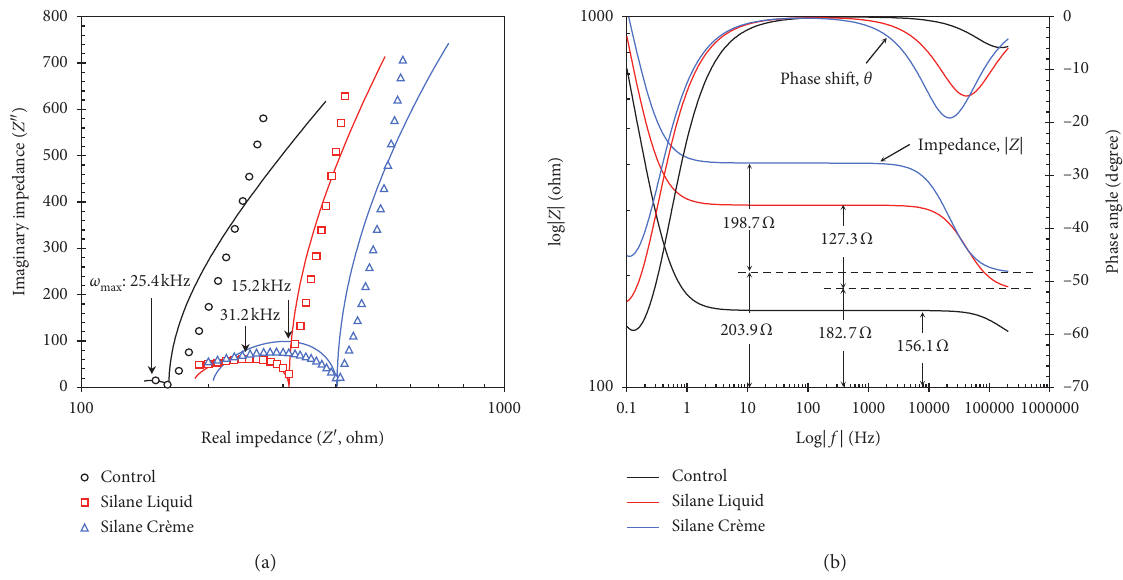
Figure 8: Electrochemical impedance response expressed by (a) Nyquist plot and (b) Bode diagram for the surface